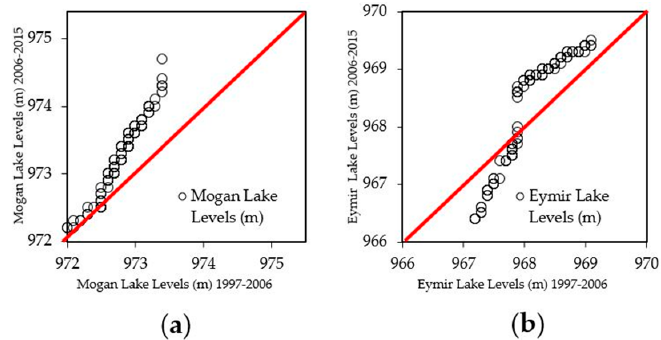
Figure 11. ST graphics of lake levels: ( a ) Mogan Lake, ( b ) Eymir Lake.